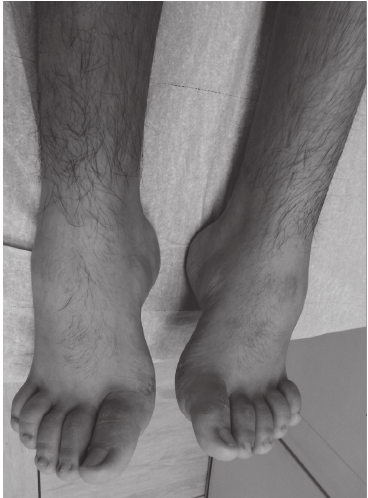
Figure 2: The feet of the 12-year-old patient show pes cavus and equinovarus deformity caused by the existing muscular